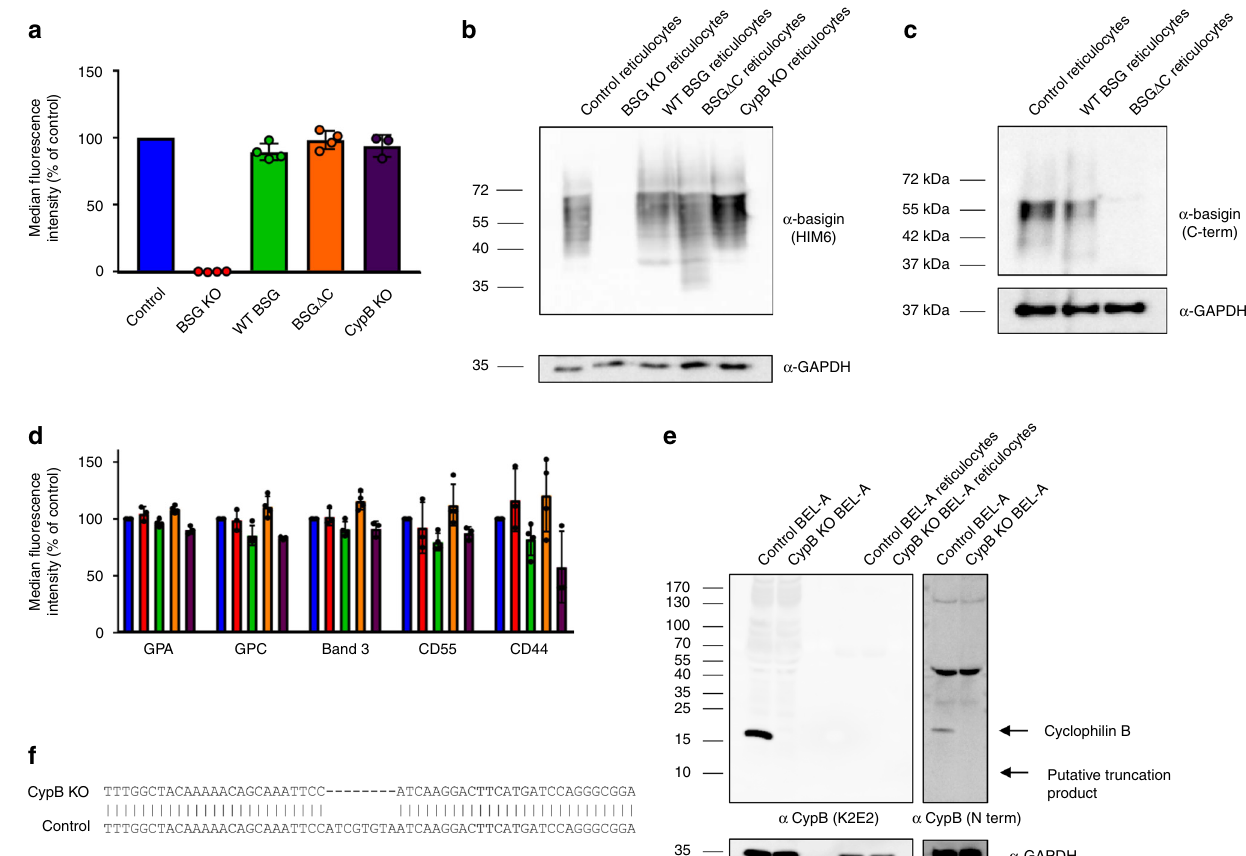
Fig. 4 Lentiviral expression of exogenous basigin in BSG KO BEL-A cells allows for ef fi cient rescue of receptor presentation in reticulocytes. a Bar graphs illustrating expression of basigin as assessed by fl ow cytometry on reticulocytes derived from indicated cell lines. Data are normalized to endogenous expression of basigin in reticulocytes derived from unedited BEL-A cells and depict the average median fl uorescent intensity across four independent cultures ( n = 4) or 3 ( n = 3) in the case of CypB KO. Error bars represent standard deviation of the mean, and individual data points are represented as fi lled circles. b Immunoblots of basigin and GAPDH in reticulocytes derived from indicated BEL-A cell lines. c Immunoblot of basigin using C-terminal basigin antibody in reticulocytes derived from indicated BEL-A cell lines. d Bar graphs illustrating expression of reported malaria receptors on reticulocytes derived from indicated cell lines. Data are normalized to endogenous expression of each receptor in reticulocytes derived from unedited BEL-A cells and depict the average median fl uorescent intensity across three or four independent cultures ( n = 3 for BSG and CypB KO, n = 4 for WT and BSGDC). Error bars represent standard deviation of the mean, and individual data points are represented as black circles. e Immunoblots of lysates from undifferentiated control (unedited) and PPIB (CypB) knockout BEL-A cells and BEL-A-derived reticulocytes with anti-cyclophilin B and anti-GAPDH antibodies demonstrate absence of cyclophilin B (and putative truncation product) expression in PPIB CRISPR gene edited cells. f Sanger sequencing of PPIB gene in edited cells reveals a homozygous 8 base pair deletion at position 284 illustrated by sequence alignment that results in a frameshift. Source data are provided as